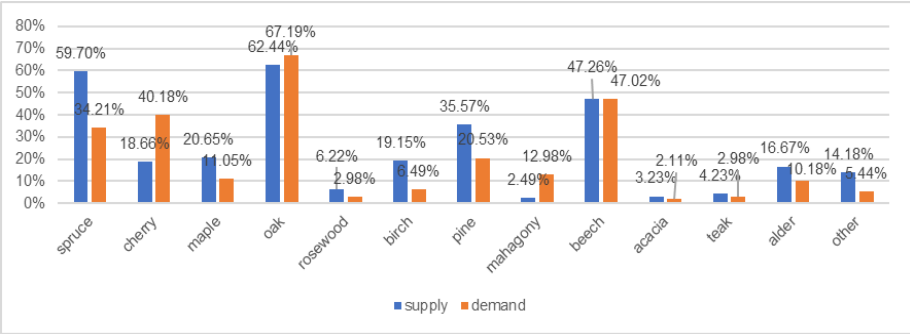
Figure 7. Comparison of demand and supply for specific types of wood plants.